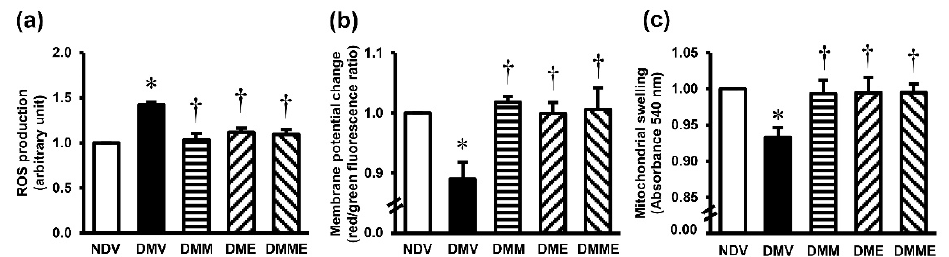
Figure 5. Effects of purple rice husk extract (PRHE) and metformin on kidney mitochondrial function. ( a ) ROS production; ( b ) membrane potential change; ( c ) mitochondrial swelling. Values are the mean ± SD ( n = 6). NDV: vehicle-treated normal group; DMV: vehicle-treated diabetic group; DMM: metformin-treated diabetic group; DME: PRHE-treated diabetic group; DMME: metformin plus PRHE-treated diabetic group. * p < 0.05 vs. NDV, † p < 0.05 vs.